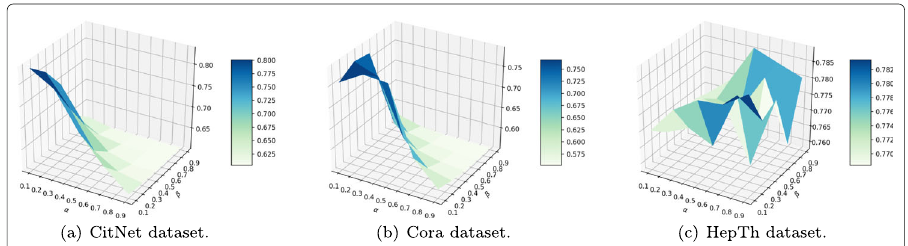
Fig. 5 Micro- F 1 scores on the three datasets in hyper-parameter sensitivity evaluation